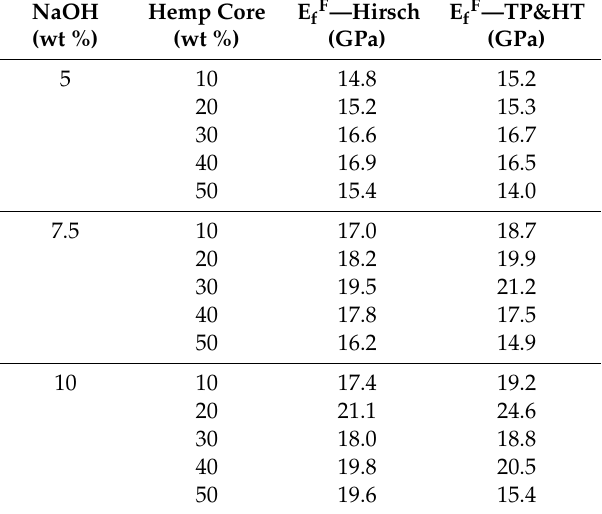
Table 3. Hemp core fibers’ intrinsic flexural modulus computed by means of Hirsch and Tsai–Pagano and Halpin–Tsai (TP&HT) models at di ff erent NaOH concentrations. NaOH Hemp Core (wt %) (wt